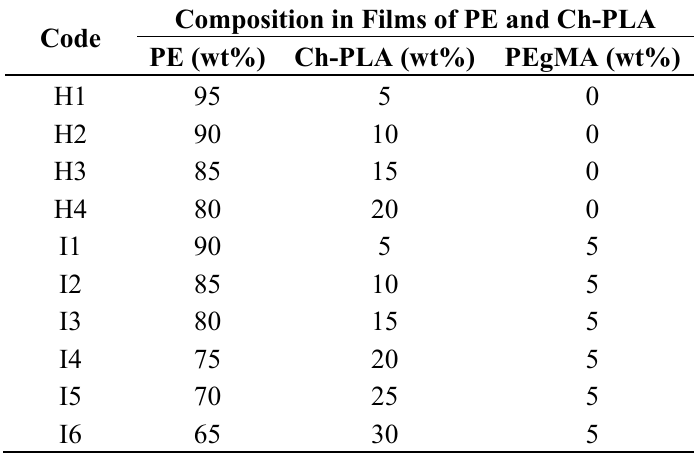
Table 1. Concentration of each component used in the preparation of blends. Composition in Films of PE and Ch-PLA Code